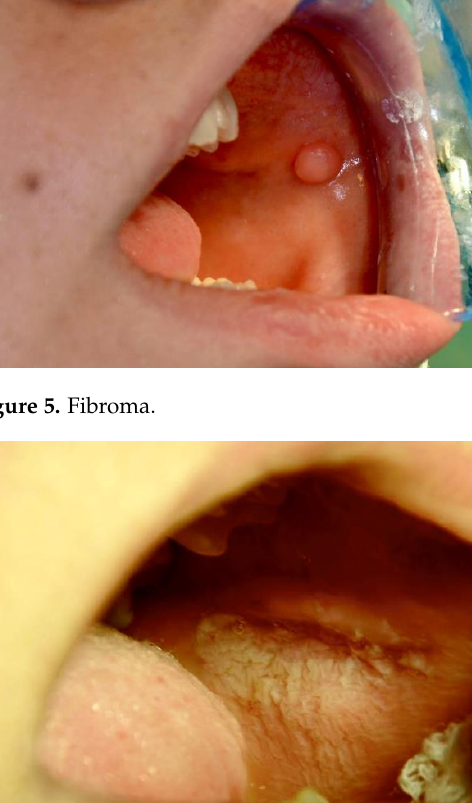
Table 6. Prevalence of oral mucosal lesions vs. age. dialysis duration and BMI values in the study group (HD). Oral Mucosal Lesions